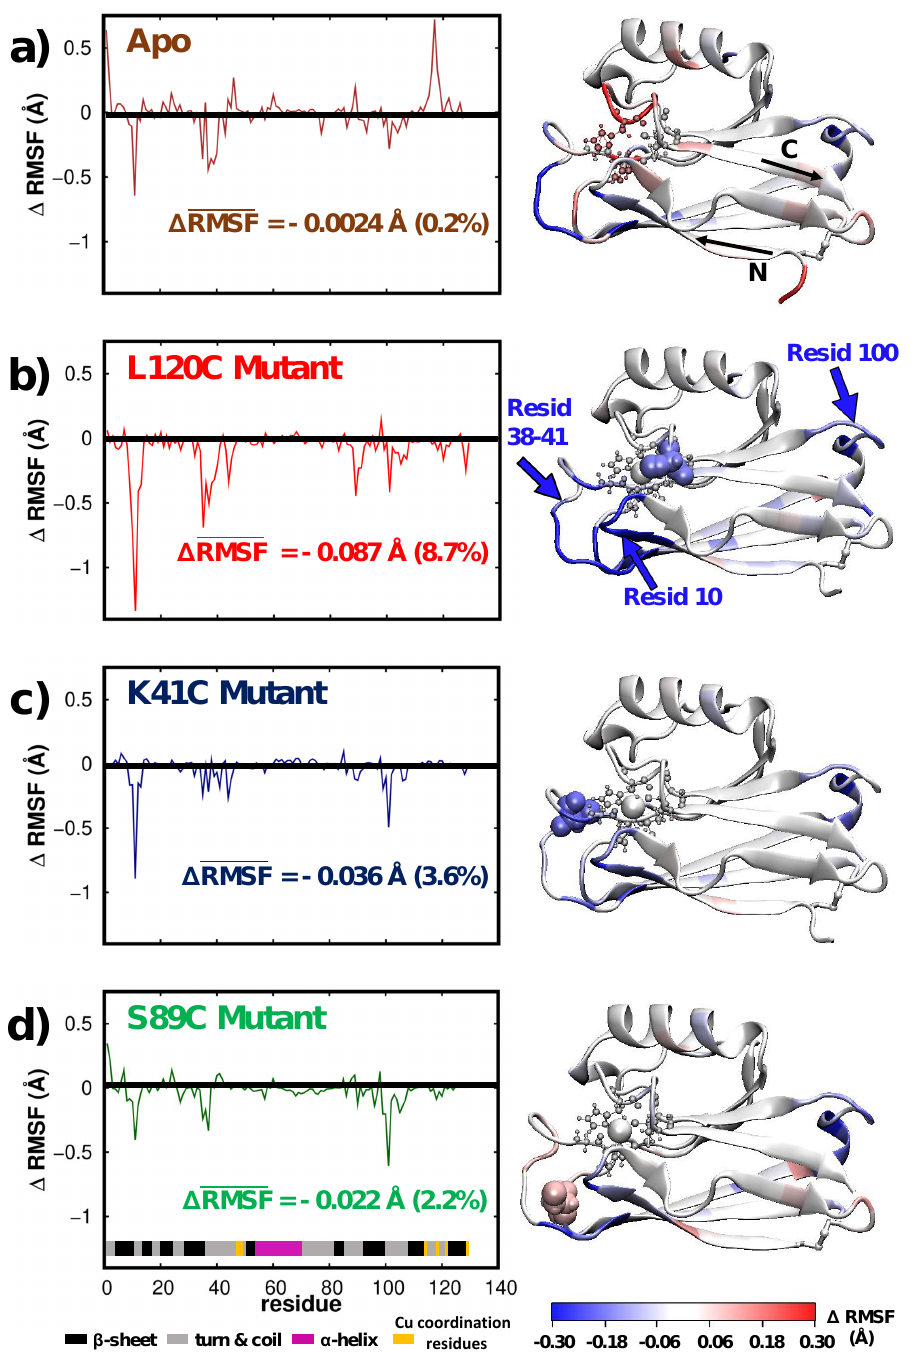
Figure 4. Differential fluctuations of the Apo and mutants with respect to the wild-type protein. ( a – d ) In the left panel we plot the ∆ RMSF ( i ) = RMSF j ( i ) − RMSF wild − type ( i ) , being (i) the amino-acid and (j) the different structures considered which are indicated inside the plot as text. Secondary structure of each amino-acid is detailed as in Figure 3a. On the right panel we represent with a color scale these values on-top of the protein’s structure. Please note that for each protein we also compute the difference between its mean fluctuation value with the mean fluctuation of the wild-type protein, · ∑ 128 RMSF ( i ) − RMSF wild − type ( i ) i.e., ∆ RMSF = 1 i = 1 128